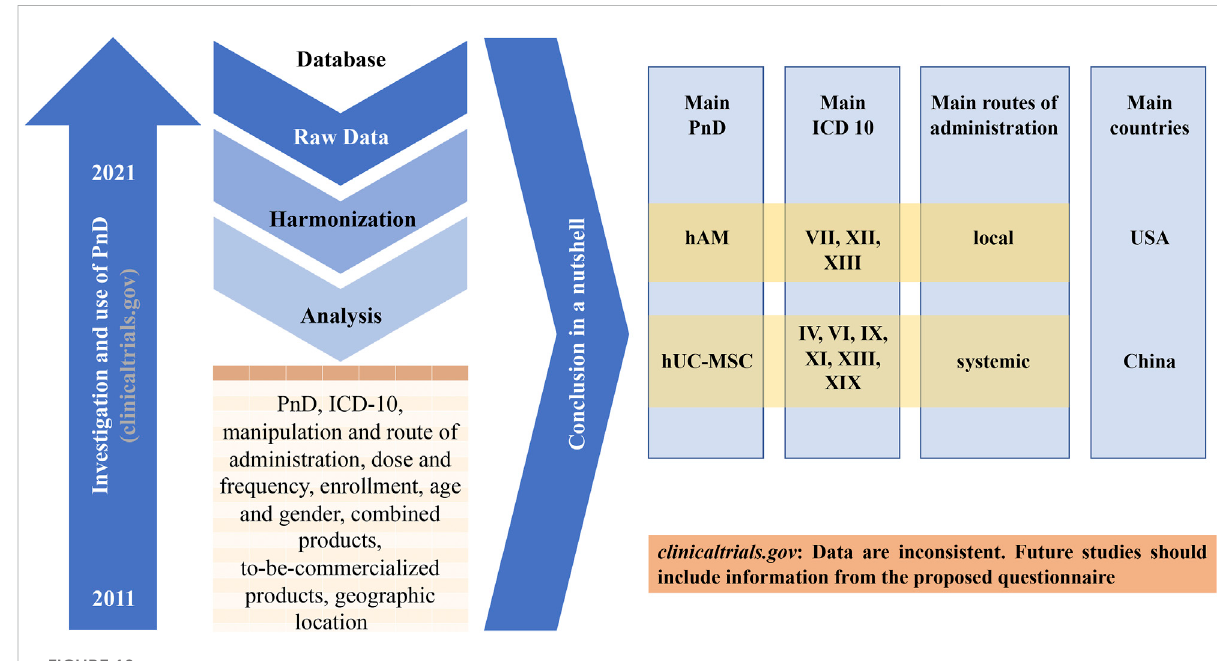
FIGURE 10 Graphical abstract of the study. The United States Clinical Trial Registration Portal (clinicaltrials.gov) was searched for 10-year period from 01/ 01/2011 to 07/10/2020 with different search-terms. From the keyword-based search, a number of clinical trials were identi fi ed. After removing studies for curing, the remaining 340 trials were analyzed. The main conclusions are shown and a more detailed registry is